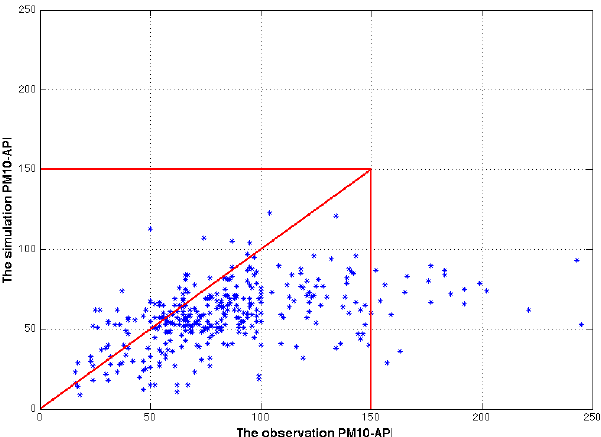
Figure 6. The observed–simulated scatter diagram of the averaged PM 10 -API in the Beijing NSAQ stations in 2010. The averaged NSAQ stations include Aoti, Dongsi, Wanliu, Chegongzhuang, Gu2cheng, Tiantan, XuanwuWSH, Nongzhanguan, Changping, Shunyi and Huairou